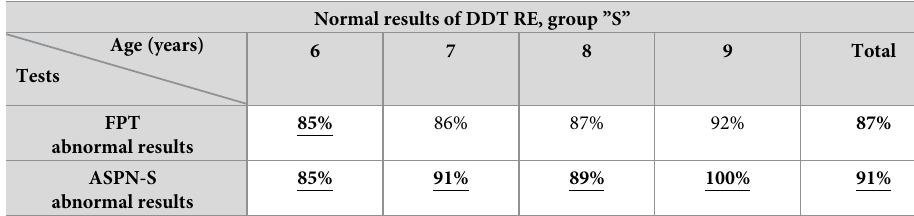
Table 7. Percentage of abnormal FPT and ASPN-S test results with a normal result of the DDT RE test and an abnormal result of DDT LE,